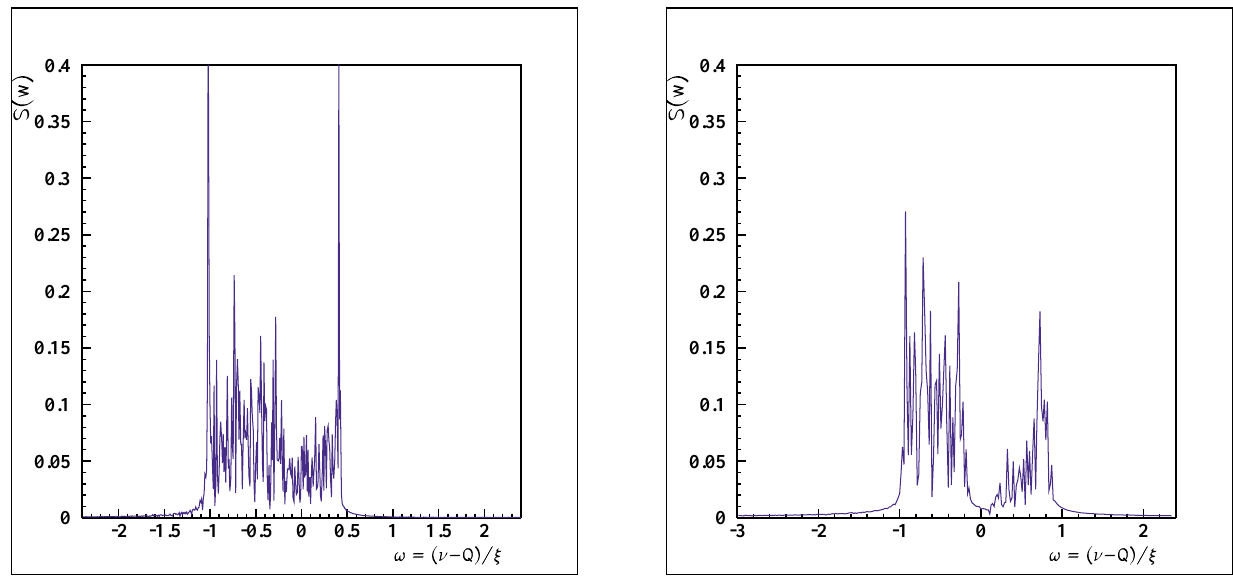
FIG. 5. (Color) Frequency spectrum of the bunch centroid motion (for 2 17 turns, N (cid:1) 10 4 macroparticles) for round beams and different fractional tunes of the second beam: 0.312 (left) and 0.313 (right). The tune of the first beam is kept at